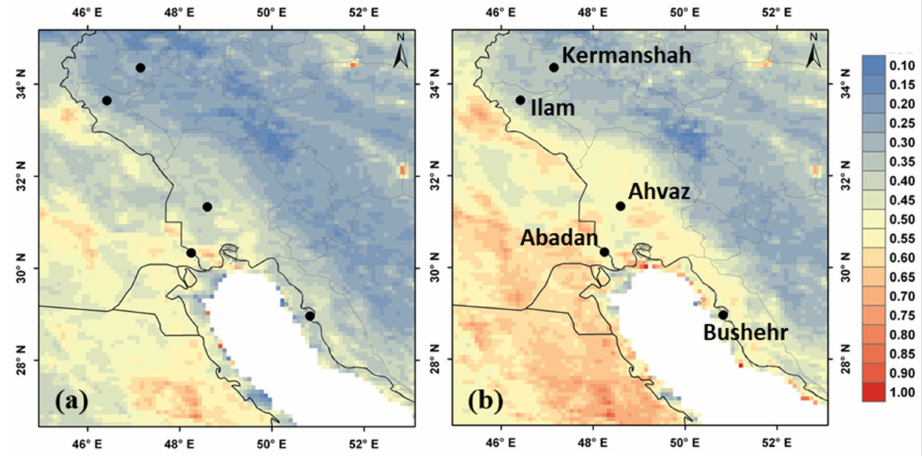
Figure 4. Mean AOD 550 spatial distribution (10 km × 10 km) during the period 2000–2018 ( a ) and during 2008–2009 ( b ) from Terra-MODIS